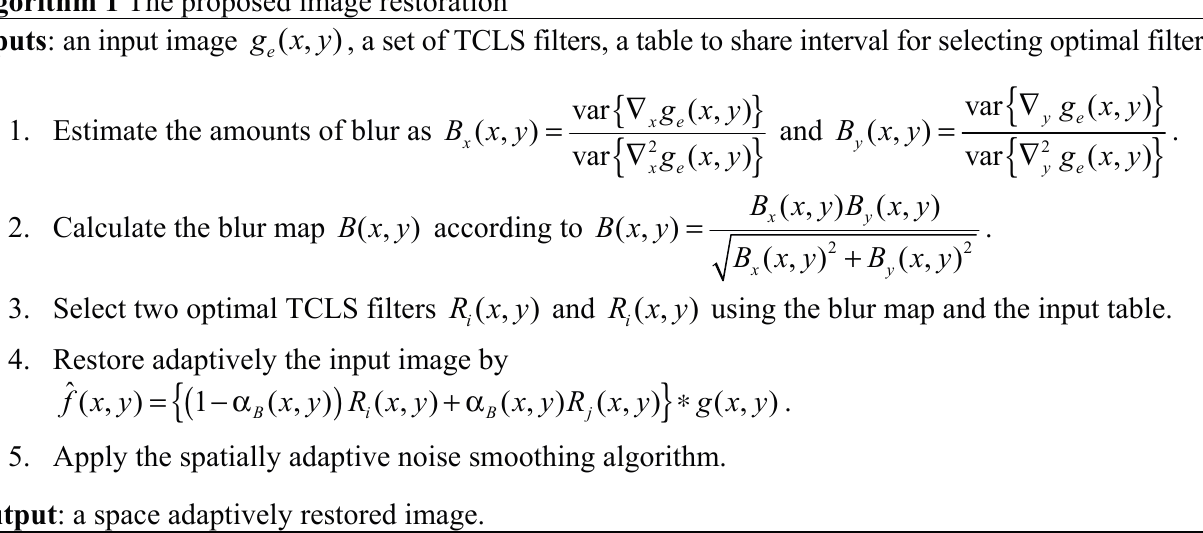
Figure 8. Procedure of the proposed region-adaptive image restoration algorithm. Algorithm 1 The proposed image